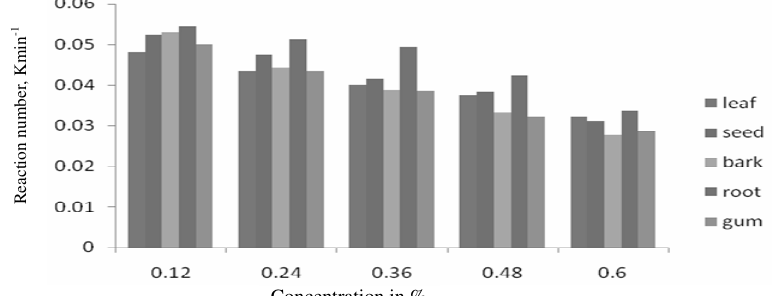
Figure 7. Variation of reaction number vs. Concentration with all five inhibitors in 3 N hydrochloric acid solution in mild steel